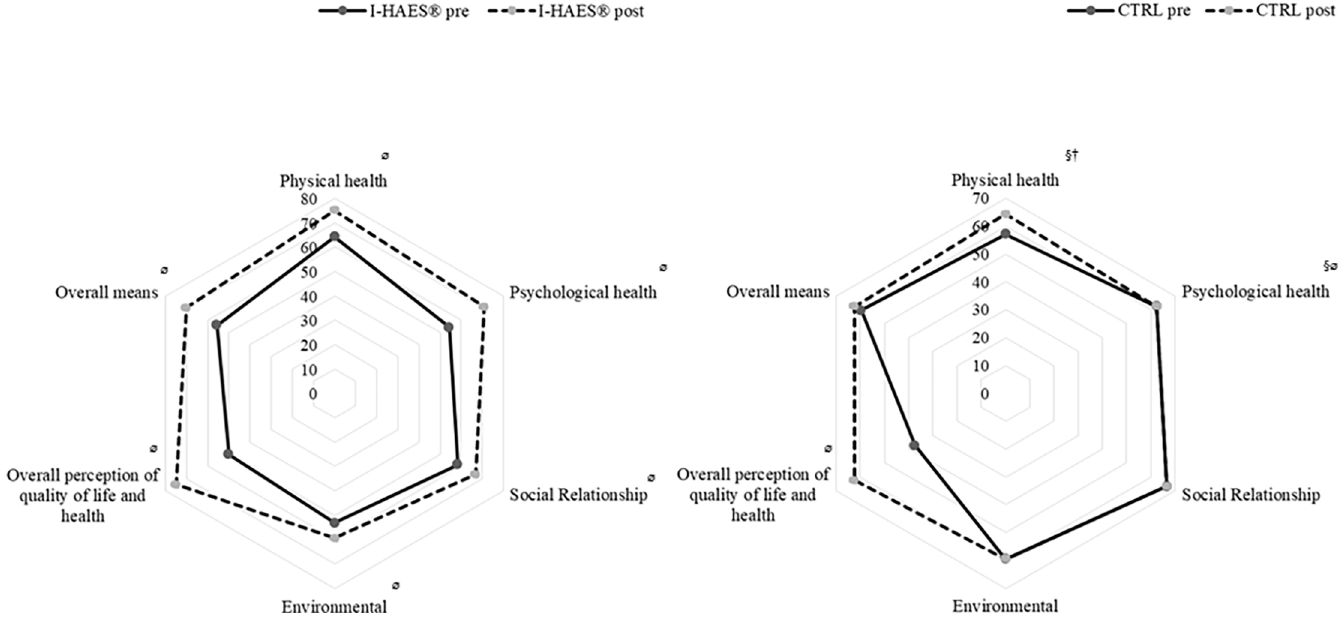
Fig 4. (Left panel): Results from the intensified HAES 1 -based intervention group WHOQOL-BREF questionnaire pre- and post-intervention. (Right panel): Results from the control group WHOQOL-BREF questionnaire pre and post intervention. I-HAES 1 , intensified HAES 1 -based intervention group; CTRL, control group. § Significant difference when compared to intensified HAES 1 -based intervention group post-intervention (P (cid:20) 0.05). ø Significant difference within group post- intervention (P (cid:20) 0.05). † Significant difference when compared to intensified HAES 1 -based intervention group pre-intervention (P (cid:20) 0.05).